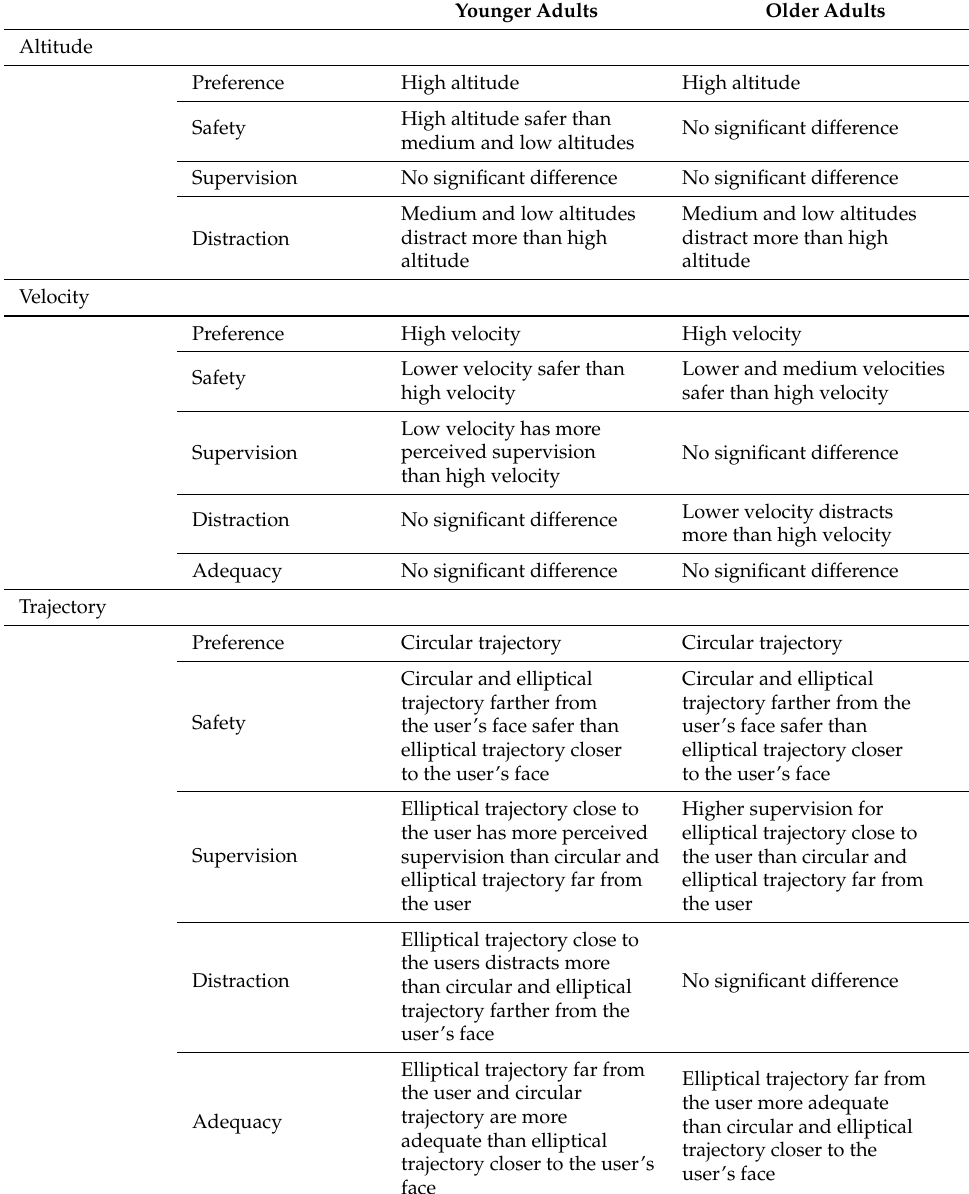
Table 7. Summary of the results for younger and older